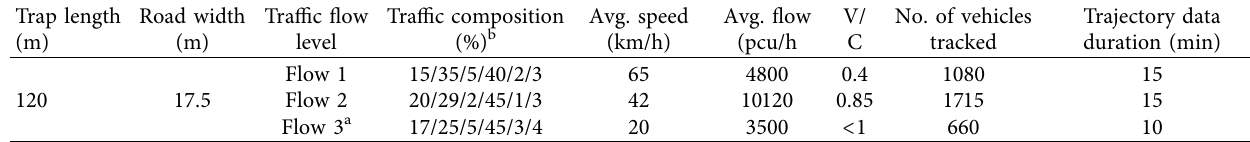
Table 1: Details of the study section (multilane urban road).